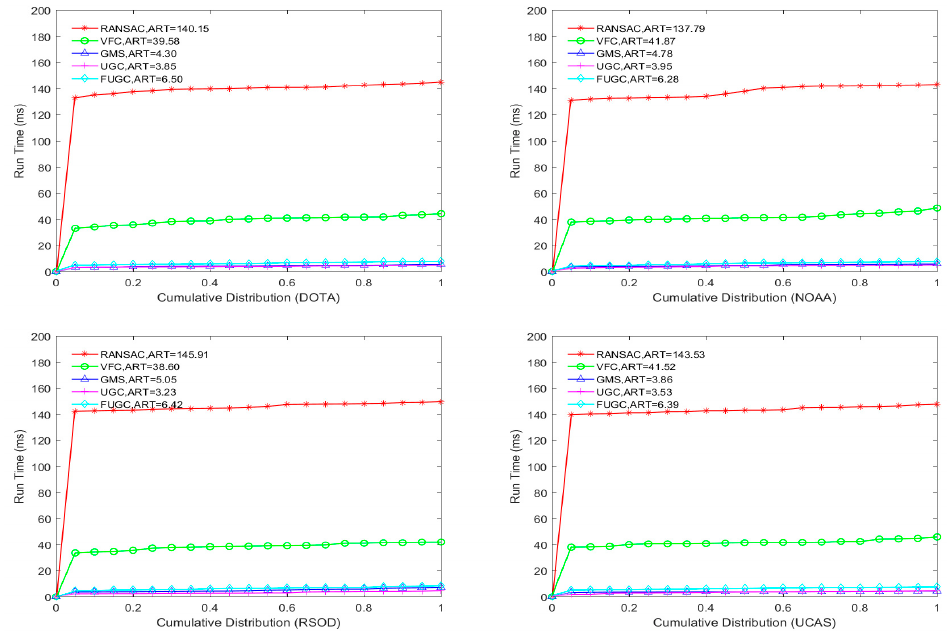
Figure 10. Quantitative comparison of the RANSAC, VCF, GSM, UGC and FUGC algorithms on the four testing datasets, namely, DOTA, NOAA, RSOD and UCAS. AIR = average inlier ratio, AF1 = average F1 score and ART = average running time.